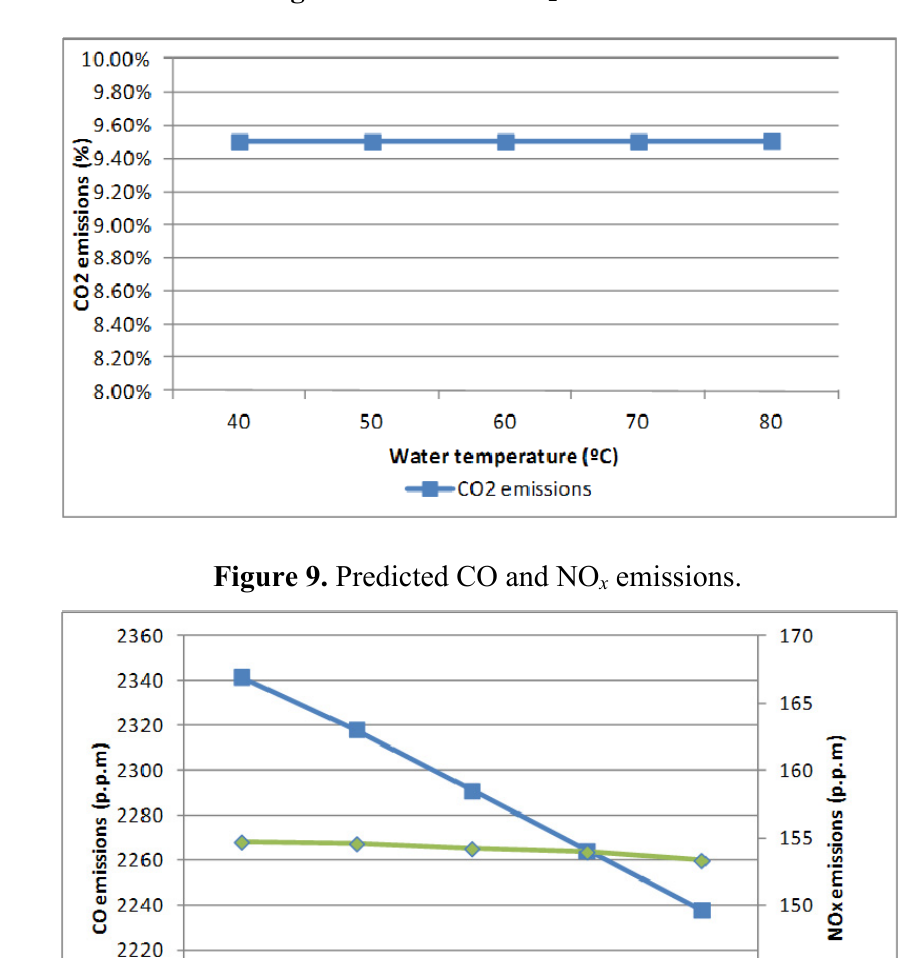
Figure 8. Predicted CO